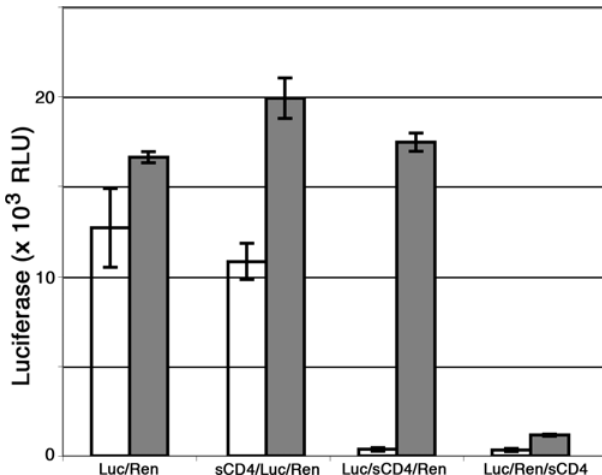
Figure 5. Inhibition of surface accessible HIV abolishes trans - infection. Mature MDDCs were sequentially exposed to HIV-Firefly luciferase (Luc) and HIV-Renilla luciferase (Ren) at 37 u C and treated at 4 u C with soluble CD4 (sCD4, 10 m g/ml) for 1 h either before, between, or after incubation with the two HIV reporters, as indicated. Cells were incubated at 4 u C during sCD4 and control treatment to prevent endocytosis of the inhibitor, and sCD4 was washed away before subsequent treatment. DCs were then co-cultured with Hos/CD4 cells, and luciferase activity was measured two days later and expressed as relative light units (RLU). Open bars, Firefly luciferase activity; grey bars, Renilla luciferase activity. Bars are mean of triplicate samples 6 standard deviation. trans -infection of CD4-negative target cells resulted in background luciferase activity, confirming that the luciferase signals were not the result of DC infection (unpublished